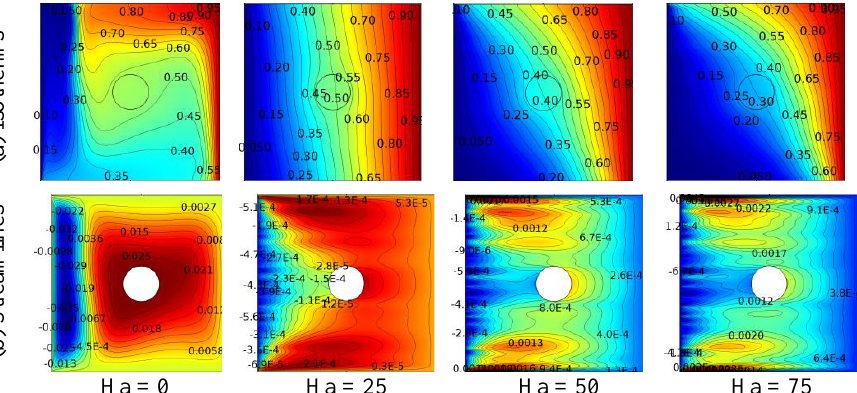
Fig. 10. isotherms (a) and Streamlines(b) for different values of Ha, with Ri = 3, φ =